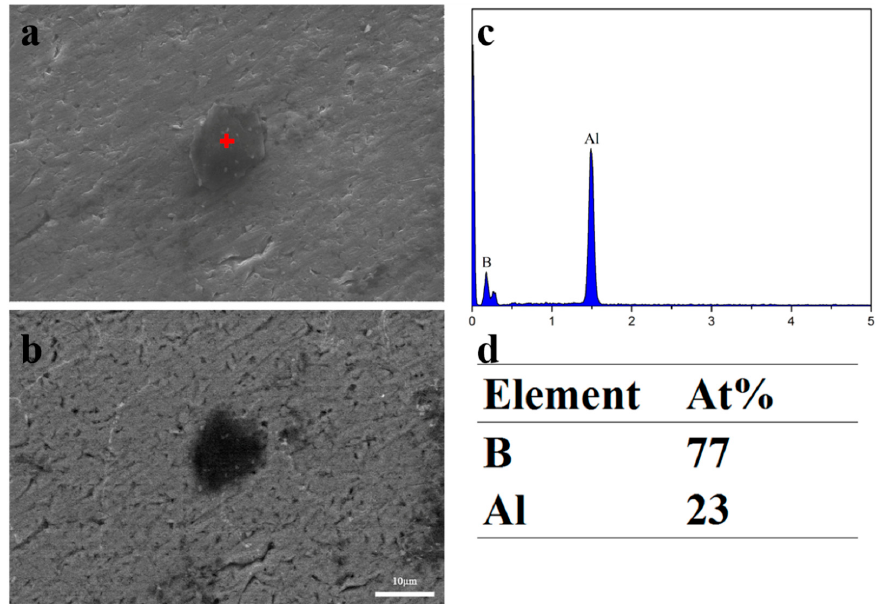
Figure 2. A typical SEM micrograph of the Al-3B master alloy ( a ) in SE (secondary electrons mode), ( b ) in BSE (back secondary electrons) mode, ( c )-( d ) the EPMA point analysis of the particle marked in (a).